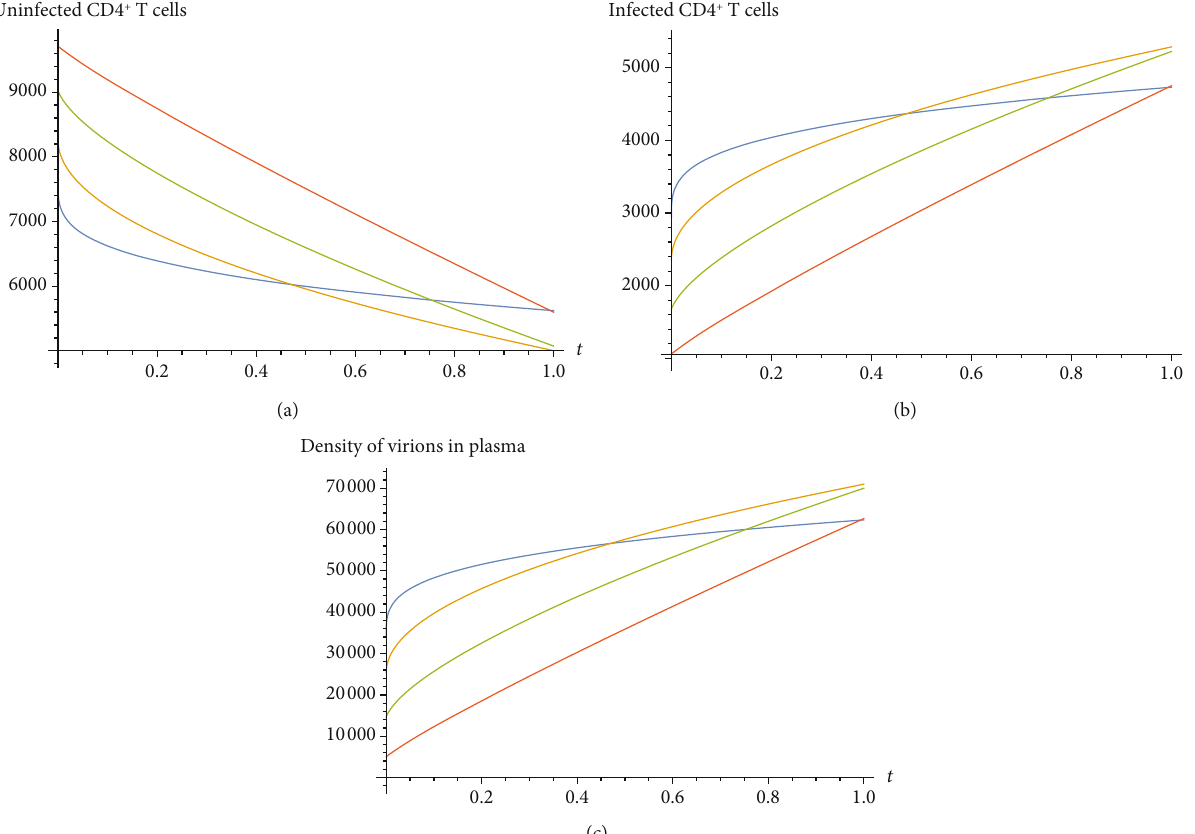
Figure 2: The graphical results to show the (a) uninfected CD4 + T cells, (b) infected CD4 + T cells, and (c) density of virions in plasma for di ff erent order fractional derivatives in sense of ABC operator, where blue represents graph for β = 0 : 3 , yellow for β = 0 : 5 , green for β = 0 : 7 , and red for β = 0 : 9 ,